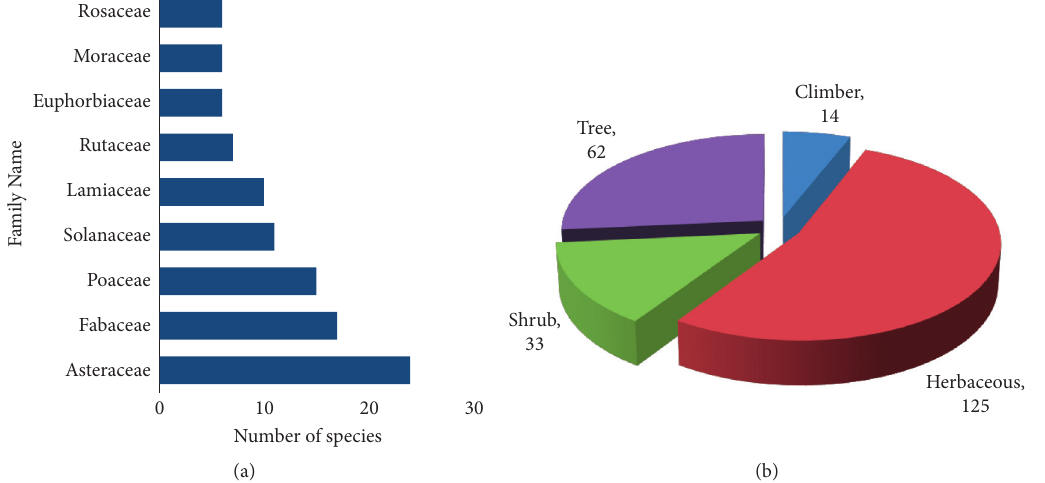
Figure 2: (a) Most dominant families of plant species and (b) habitats of plant species in the study area.